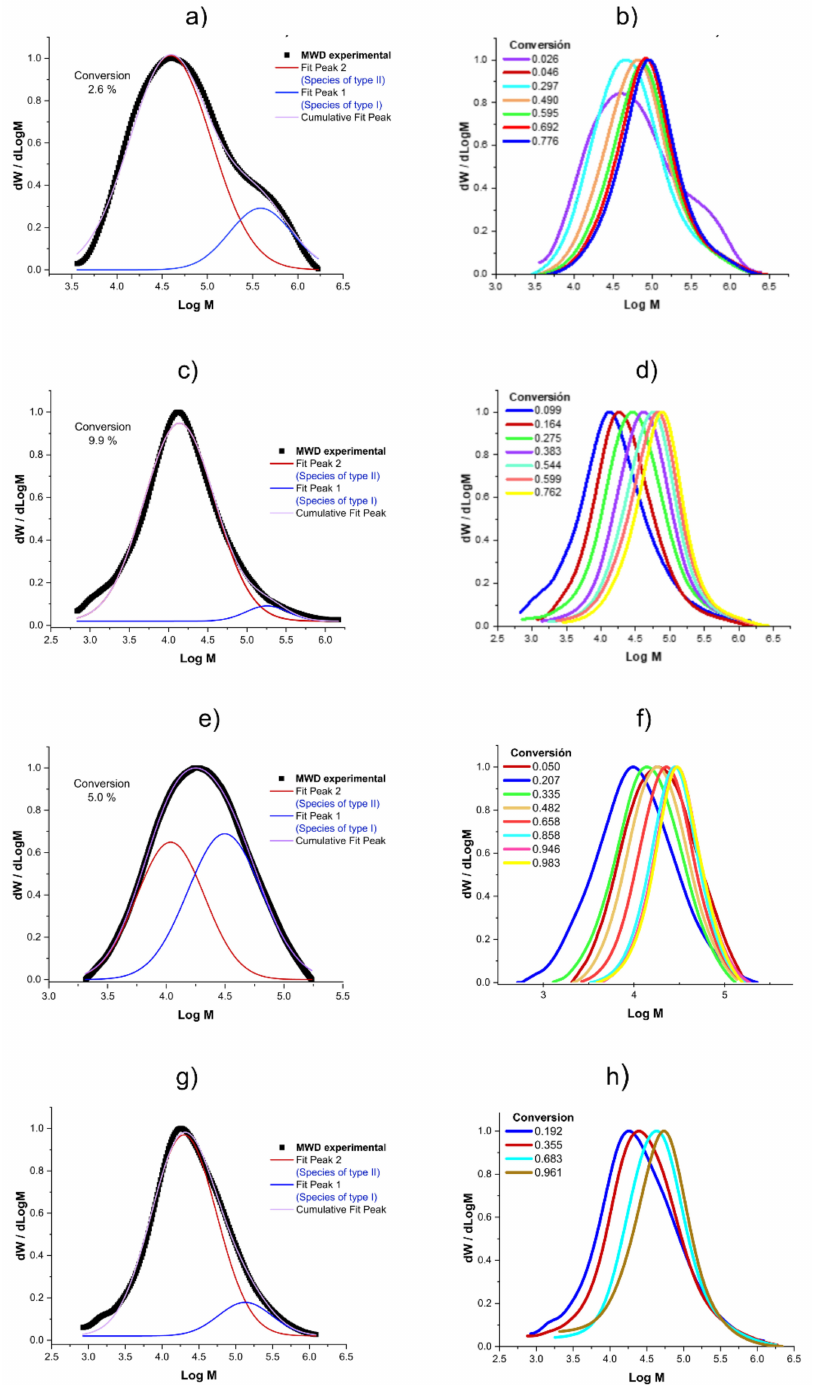
Figure 4. Molecular weight distributions: ( a ) MWD and the deconvolution for Exp. 1 at 2.6% of conversion; ( b ) Evolution of the MWD in conversion for Exp. 1; ( c ) MWD and the deconvolution for Exp. 3 at 9.9% of conversion; ( d ) Evolution of the MWD in conversion for Exp. 3; ( e ) MWD and the deconvolution for Exp. 4 at 5% of conversion; ( f ) Evolution of the MWD in conversion for Exp. 4; ( g ) MWD and the deconvolution for Exp. 5 at 1.9% of conversion; and ( h ) Evolution of the MWD in conversion for Exp. 5. Figure S1 in the Supporting Information shows the plots for Exp